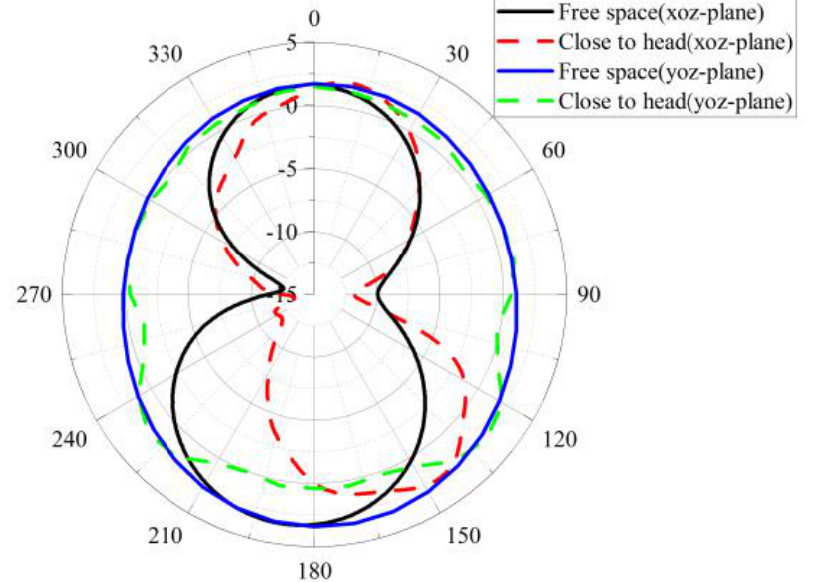
Figure 10. Comparison of simulated radiation patterns in free space and close to the human head at 6 GHz.